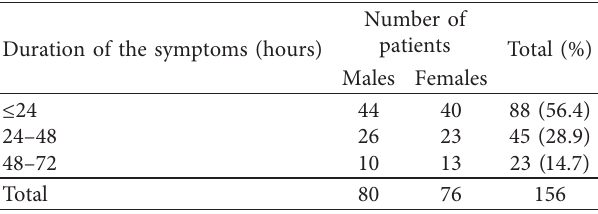
Table 3: Distribution of the patients according to duration of the symptoms.